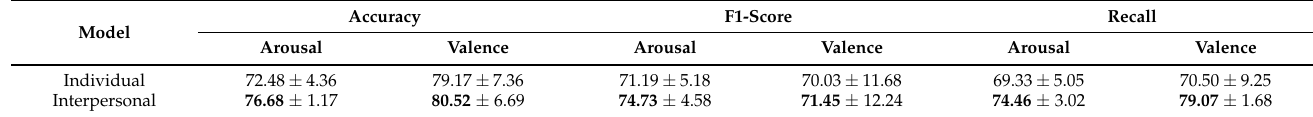
Table 5. The main experiment result for cross-modality